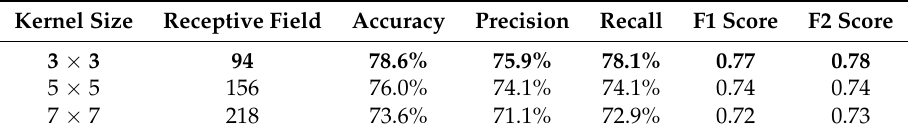
Table 2. Comparison between different kernel sizes with the same convolutional layers, and the 3 × 3 kernel size is the most effective. (Conv Layer: 5-Conv layer).